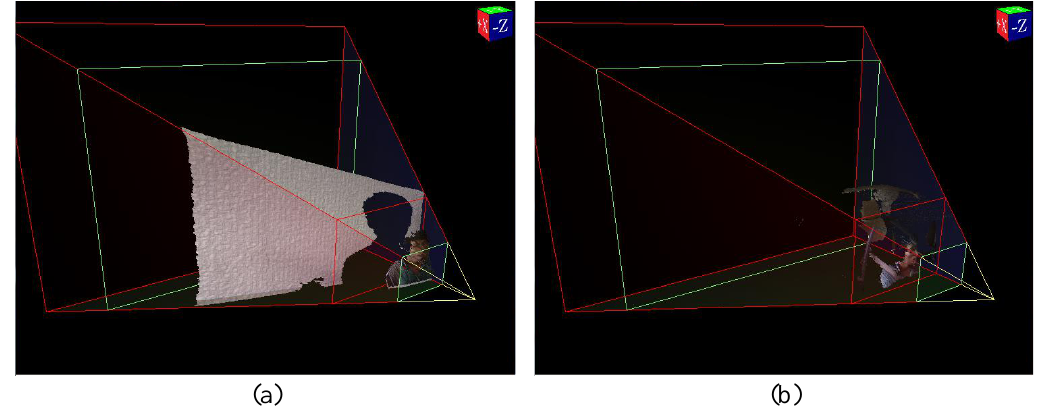
Figure 3. Point-cloud at different distance: ( a ) in-door, ( b )